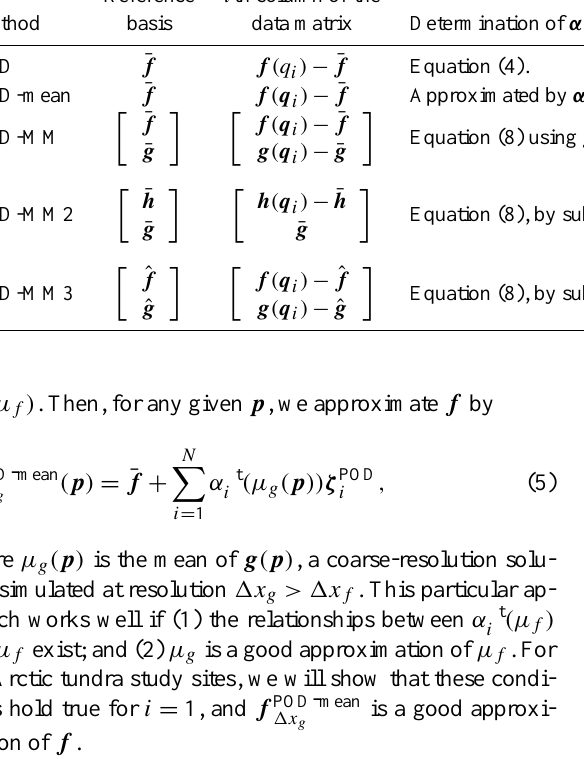
- MM - MM2 - MM3 , ζ g, POD and ζ g, POD are POD bases for i i i